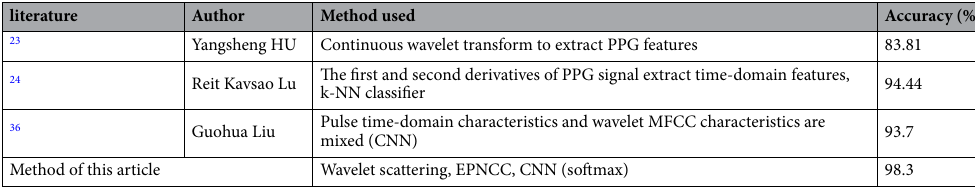
Table 10. Pulse classification performance